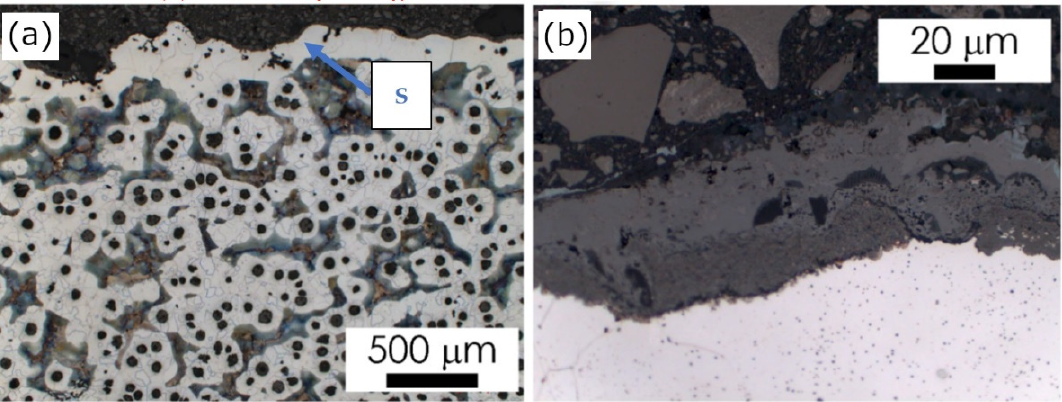
Figure 7. Casting No. 4, prepared in alkaline molding sand No. 4, LM etched with 4% Nital; ( a ) microstructure of alloy, microscope magnification 100 ×, ( b ) microstructure of the superficial zone (S), microscope magnification 1000 × .